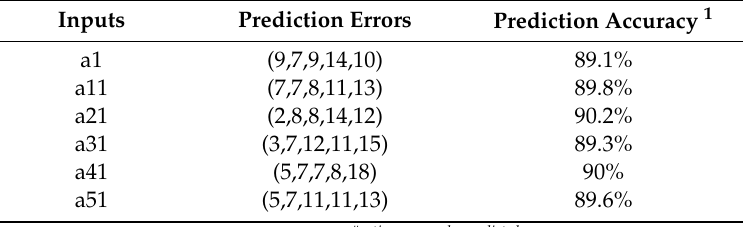
Table 6. Testing results based on the disordered dataset.